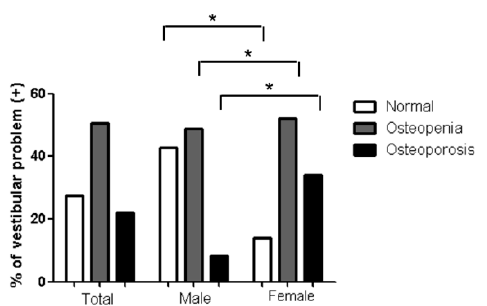
Figure 3. Prevalence of osteoporosis in the vestibular problems in the modified Romberg test in each group (* p < 0.05).